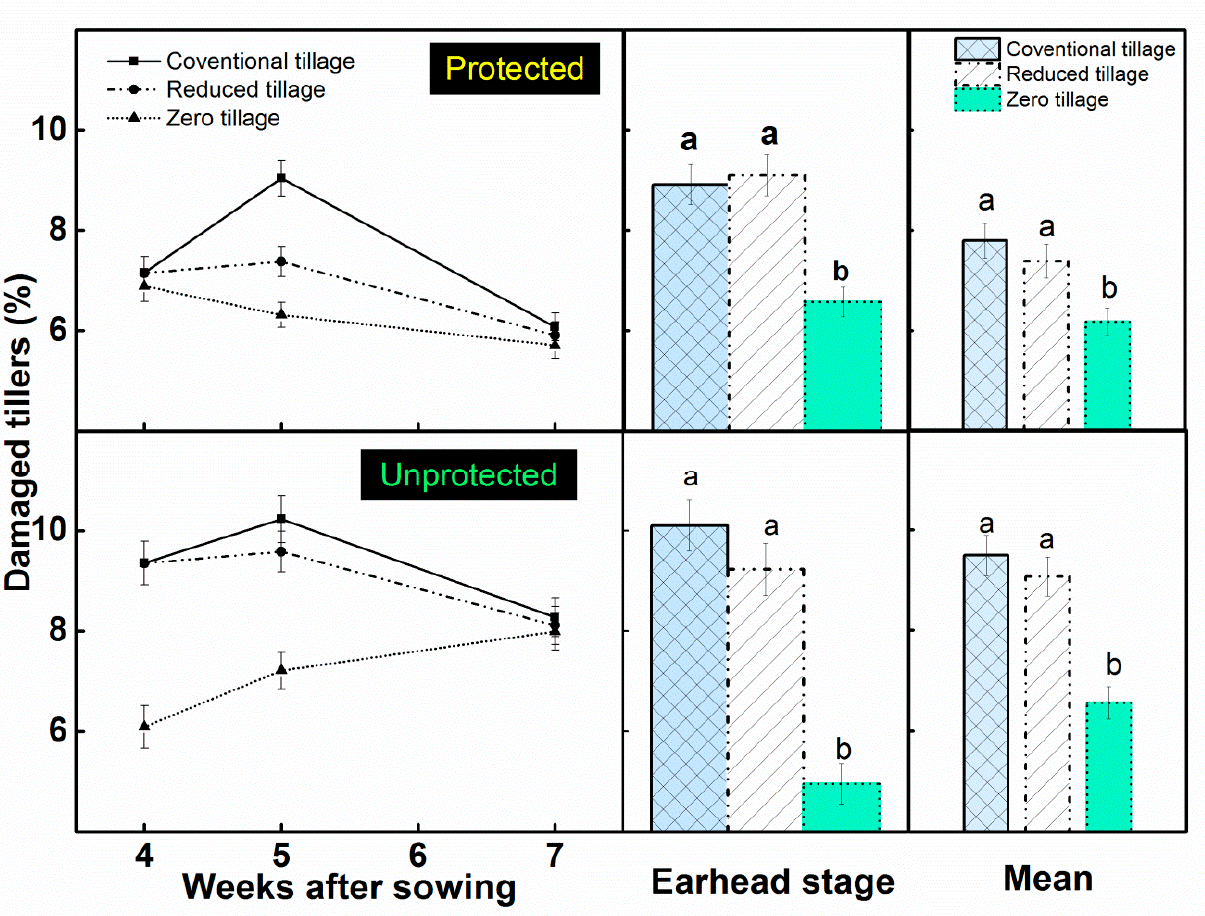
Figure 5. Damage from termites, Odontotermes obesus (Rambur) and Microtermes obesi (Holmgren), in wheat grown under 3 tillage practices during 2016–2017 and 2017–2018 (pooled). Bars with same letters are not significantly different at p < 0.05. Error bars denote ±1 SE.